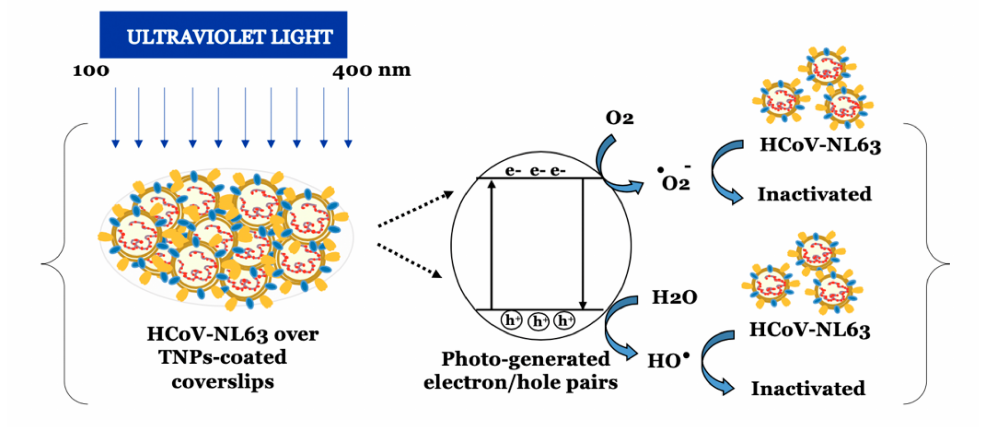
Figure 16. Principle of photocatalytic inactivation of the human alpha coronavirus HCoV-NL63 by UV irradiation that produces “electron-hole (e − -h + )” pairs and ROS, together with hydroxyl and superoxide radicals on the surface of TiO 2 NPs (TNPs). Figure reprinted from Ref. [197] under